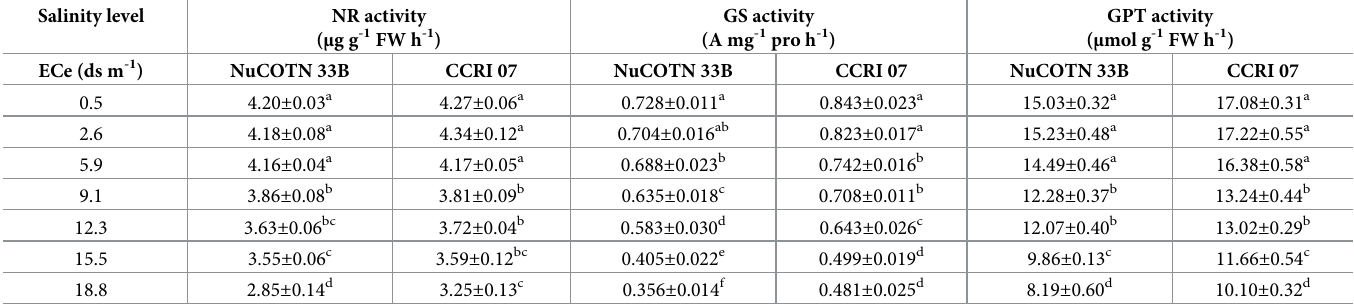
Table 4. Impacts of salinity gradient on nitrate reductase (NR), glutamine synthetase (GS) and glutamic-pyruvic transaminase (GPT) activities in squares of two Bt cotton cultivars under greenhouse conditions in 2017 (n = 4). Different letters represent significant differences in the same column (Duncan multiple range tests, P <